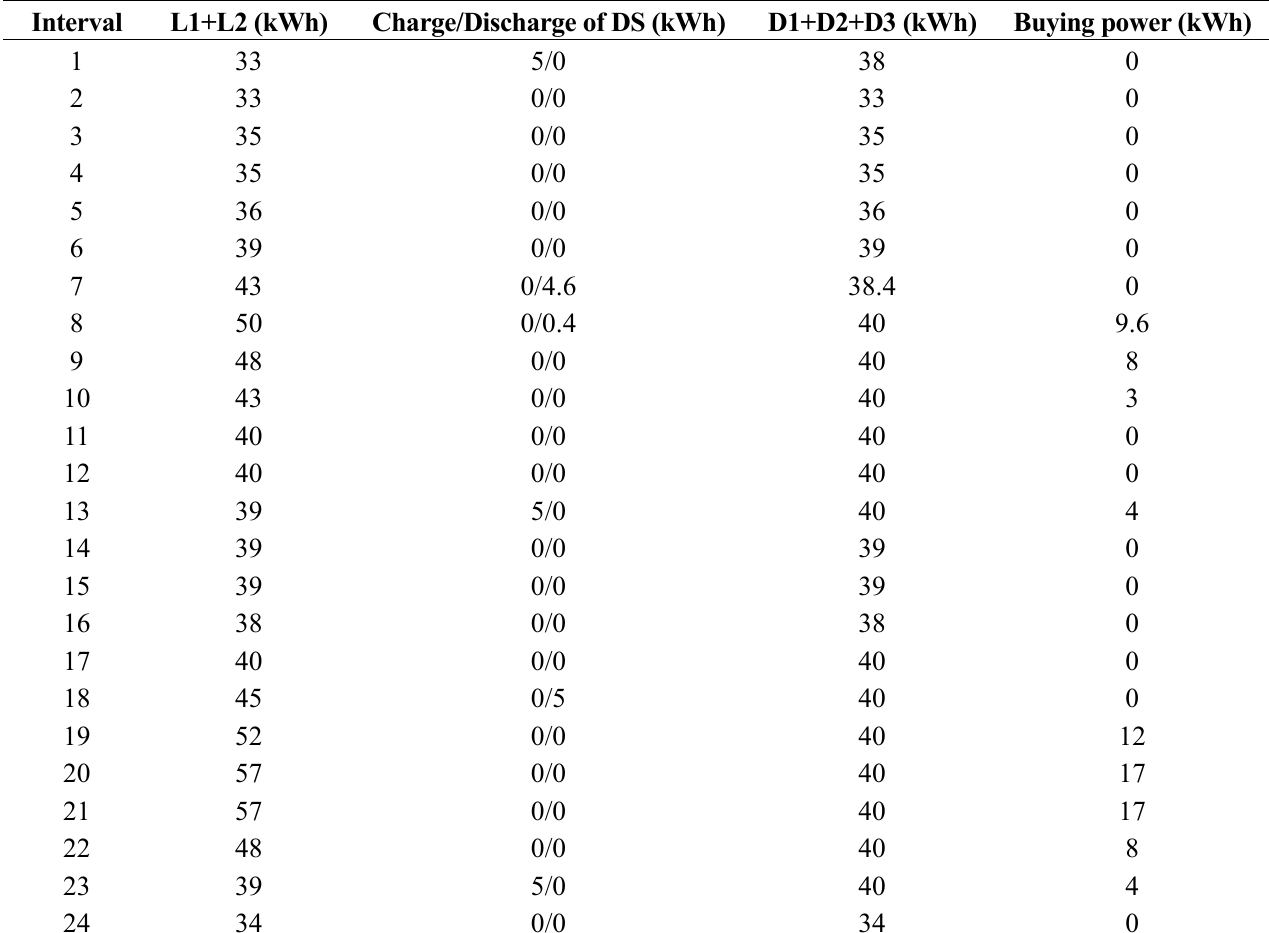
Table 3. Power balance of microgrid in 24 intervals.